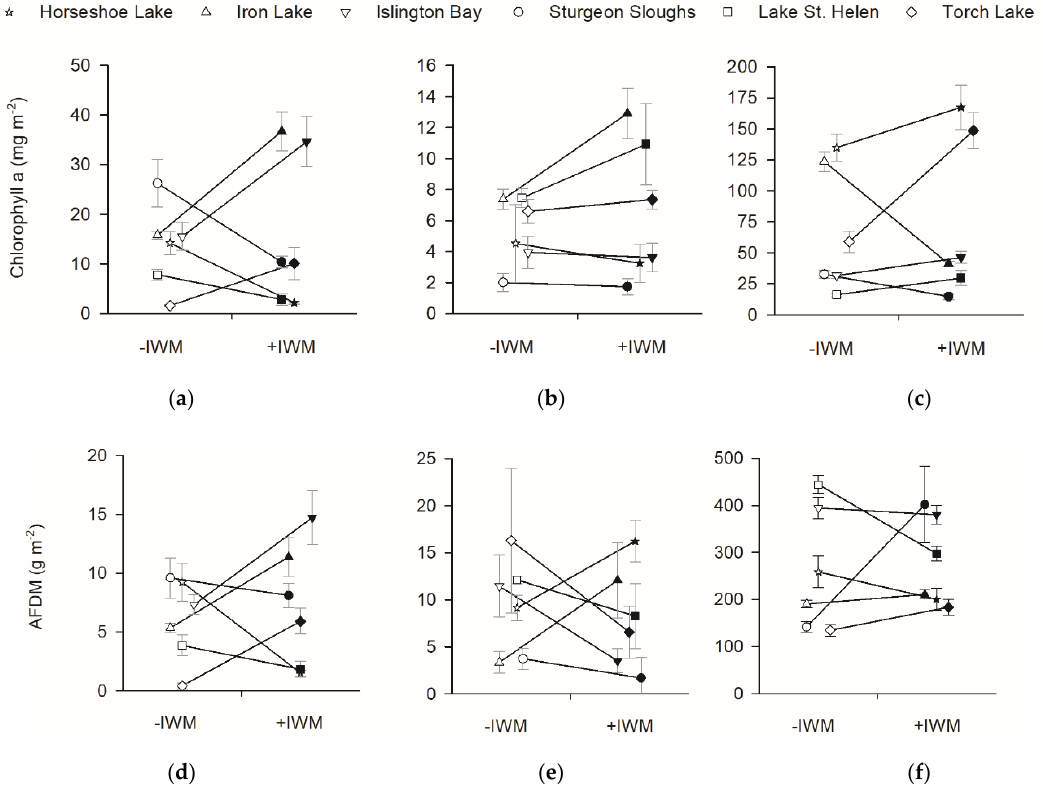
Figure 5. Standing crops of chlorophyll a and ash free dry mass (AFDM) for ( a , d ) epiphyte, ( b , e ) phytoplankton, and ( c , f ) benthic periphyton. Means ± 1 SE are represented by symbols with error bars. Shaded symbols represent +IWM plots and unshaded symbols represent − IWM plots for each waterbody. Lines connecting symbols illustrate differences in paired plots. Symbols are offset horizontally to aid in interpretation of error bars.